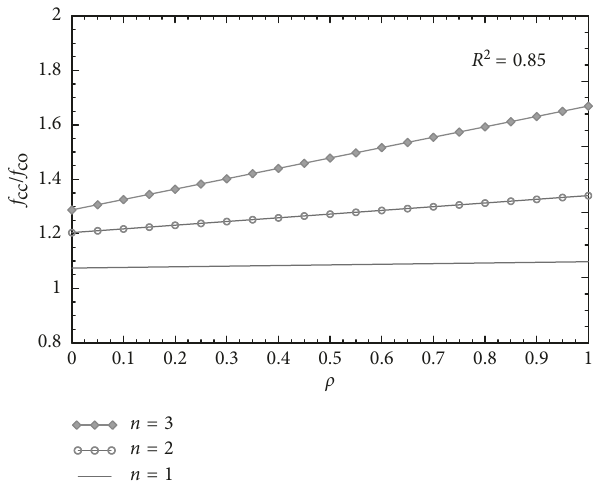
Figure 6: 3D figure of Equation (5) in terms of f experimental data (blue points) and the numerically simulated data (red points).